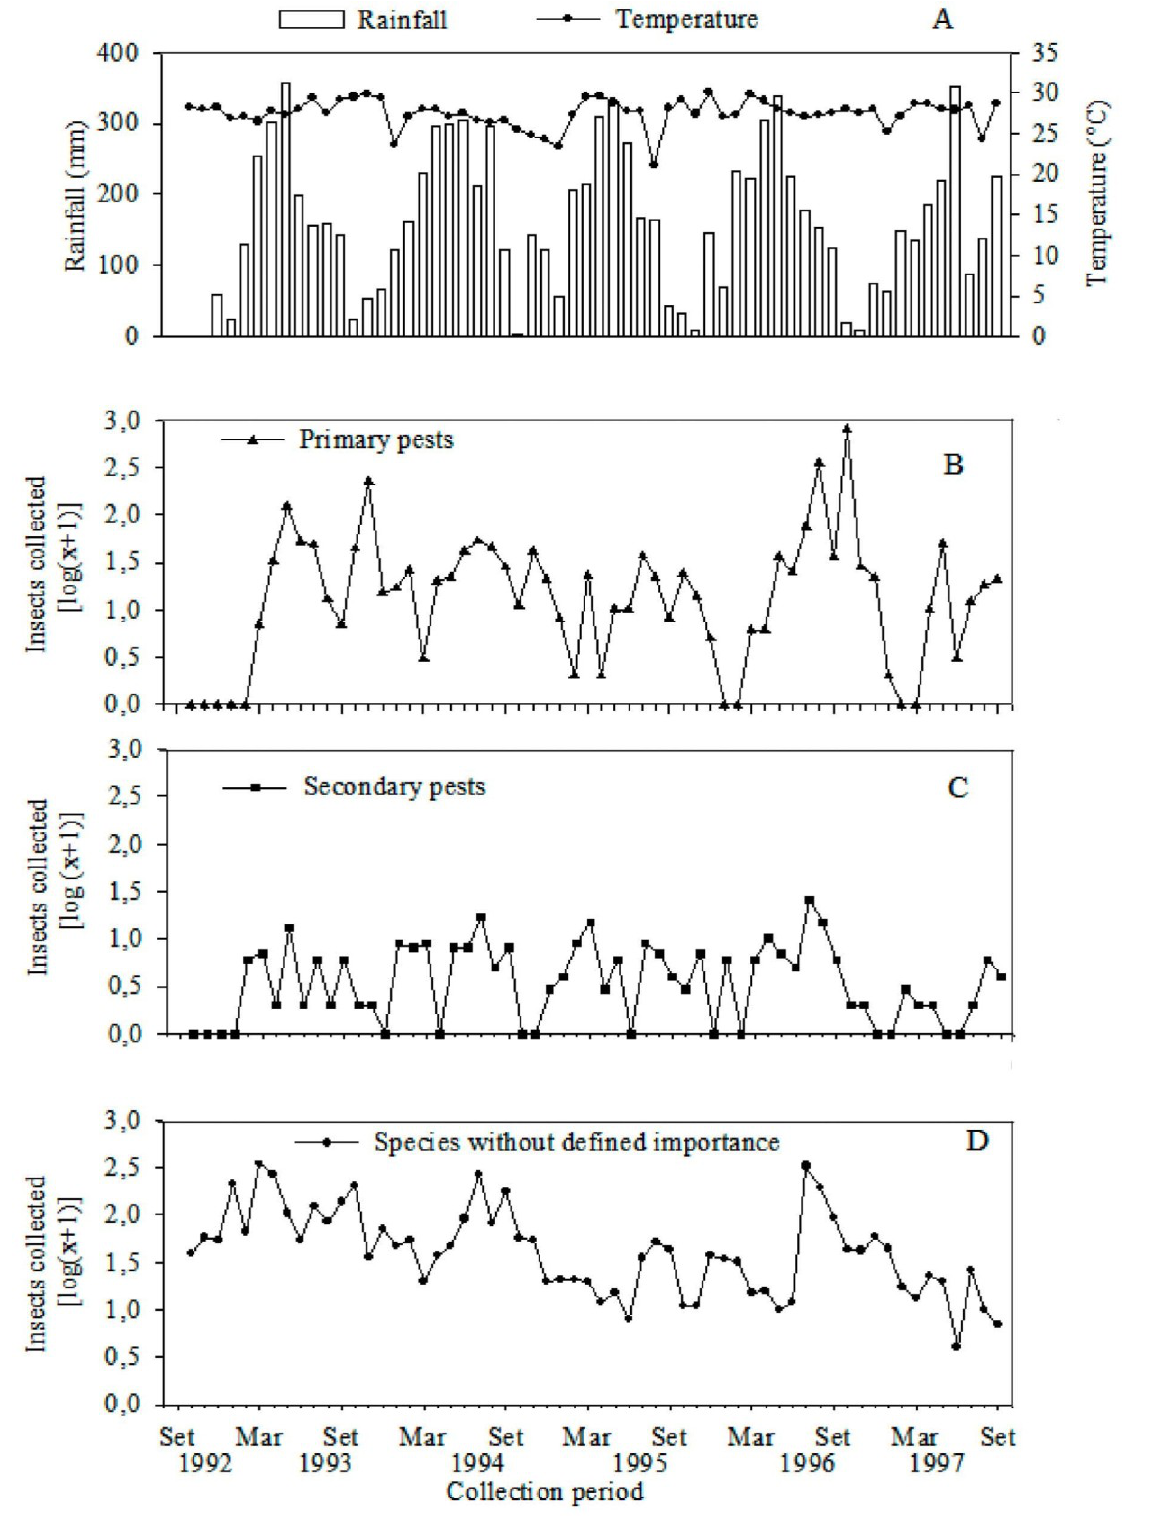
Figure 3 Rainfall (mm) and temperature (°C) ( A ), population dynamics of primary pests ( B ), secondary pests ( C ), and species with no defined importance to eucalypts ( D ) in Pacanari, Pará State,